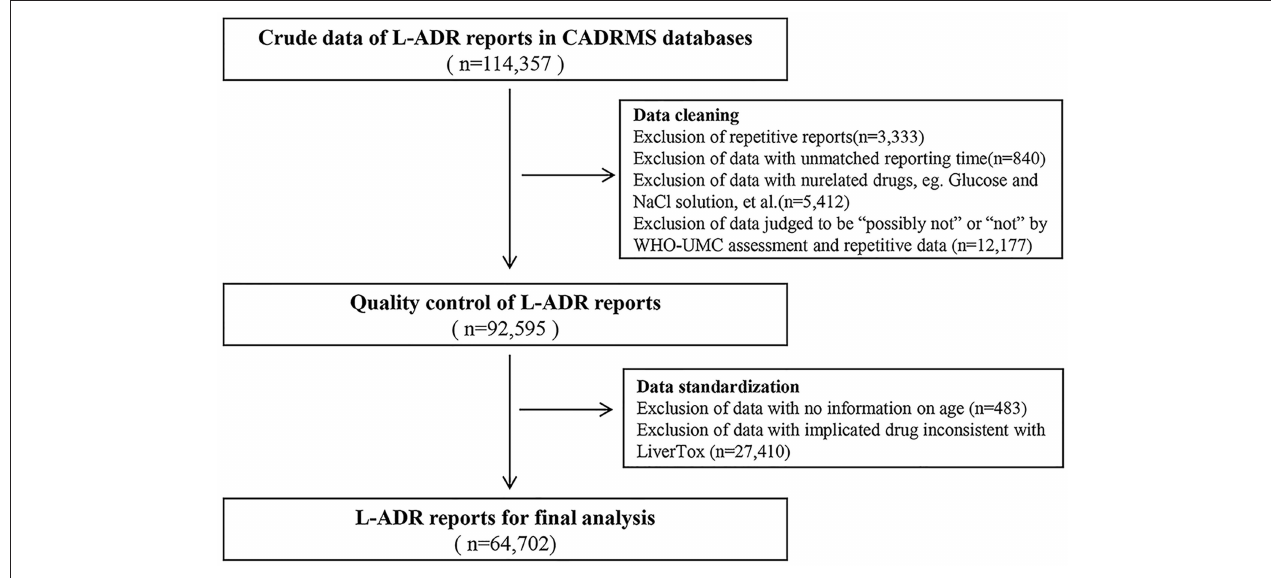
FIGURE 1 | Data acquisition flowchart.